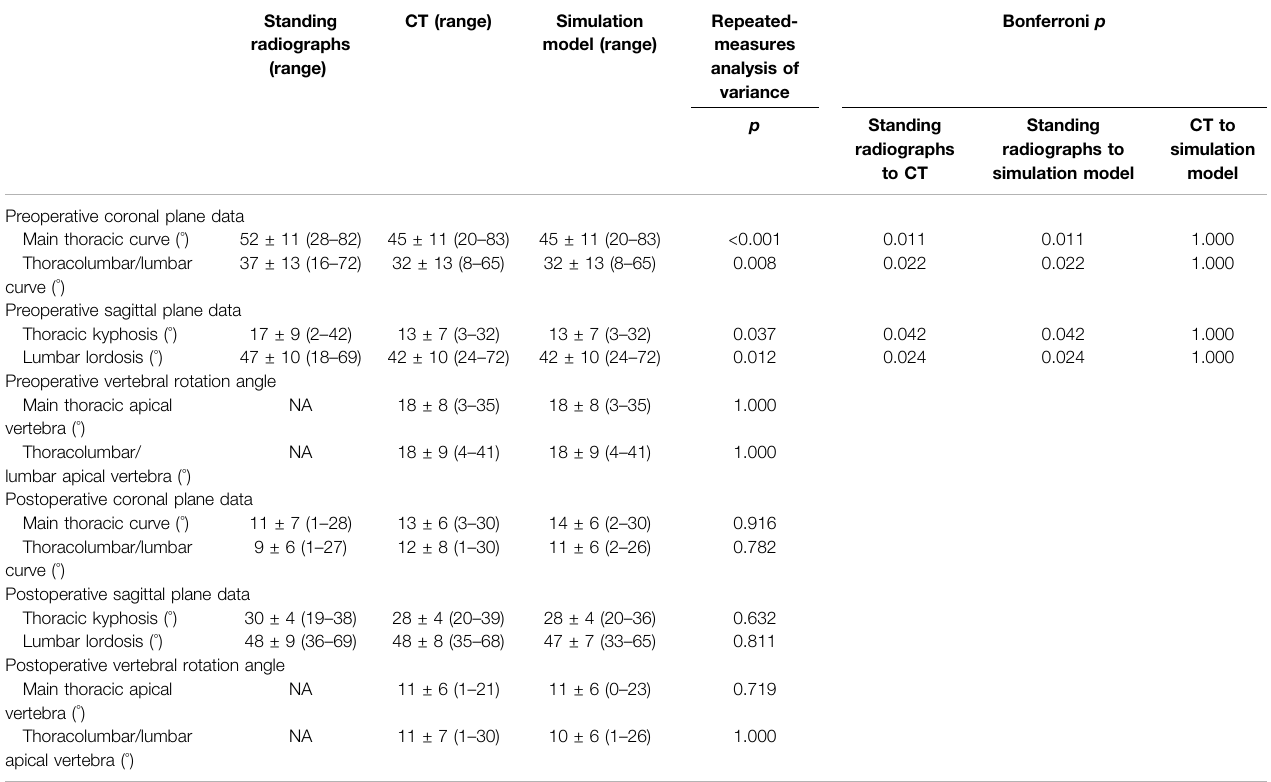
TABLE 3 | Radiographic and CT